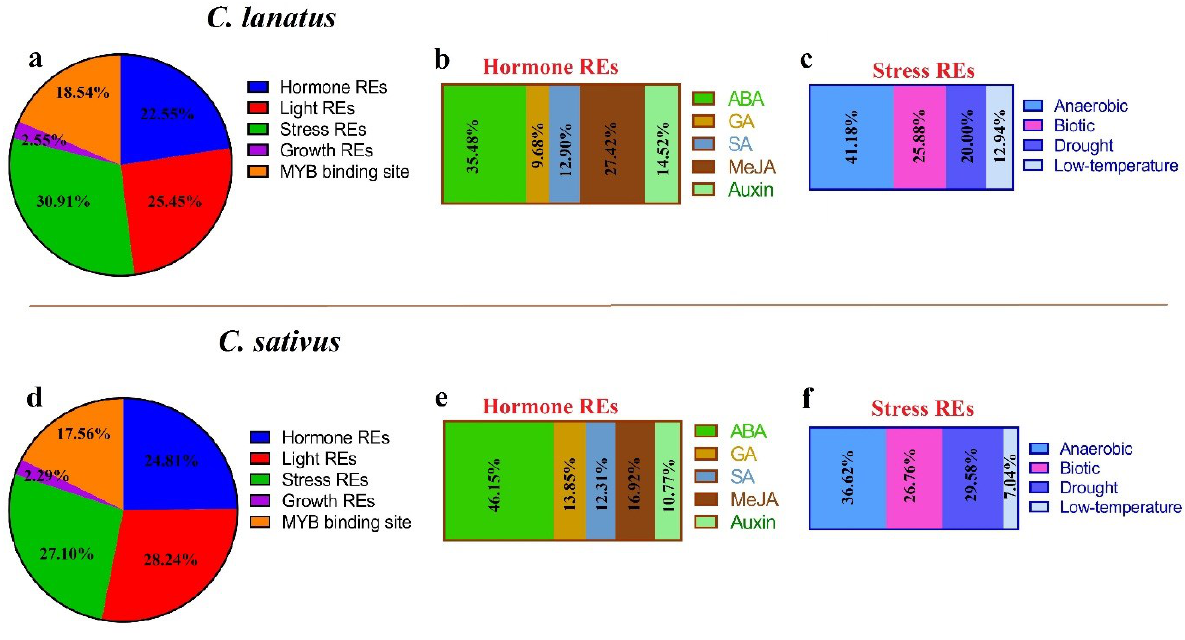
Figure 8. Proportion of cis -regulatory elements in upstream site (promoter regions) of MGT genes. The cis -regulatory elements were classified in hormone-responsive elements (REs), light REs, stress REs, growth REs, and MYB binding site in C. lanatus ( a ) and C. sativus ( d ). The percentage of cis -regulatory elements related to hormone REs in C. lanatus ( b ) and C. sativus ( e ), and stress REs in C. lanatus ( c ) and C. sativus ( f ). More details are provided in Table S3.